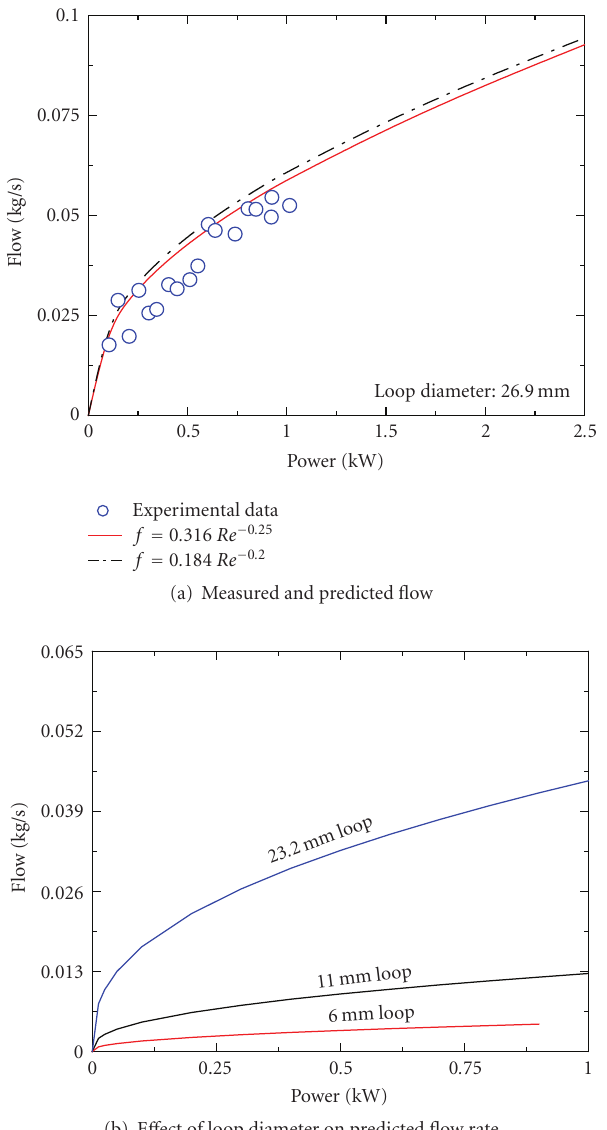
Figure 2: The steady state flow rate variation with power for di ff erent loop diameters.